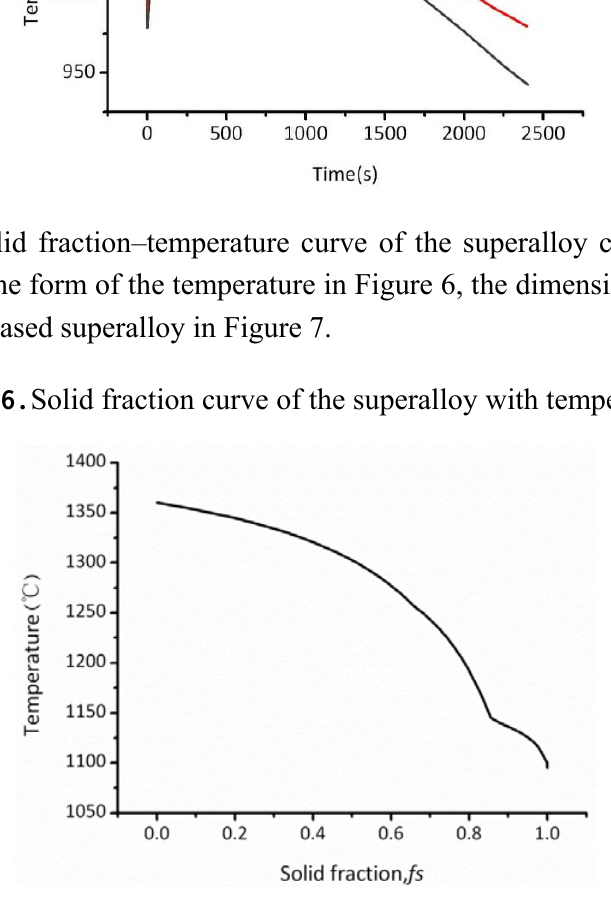
Figure 7. The function between liquid fraction and dimensionless